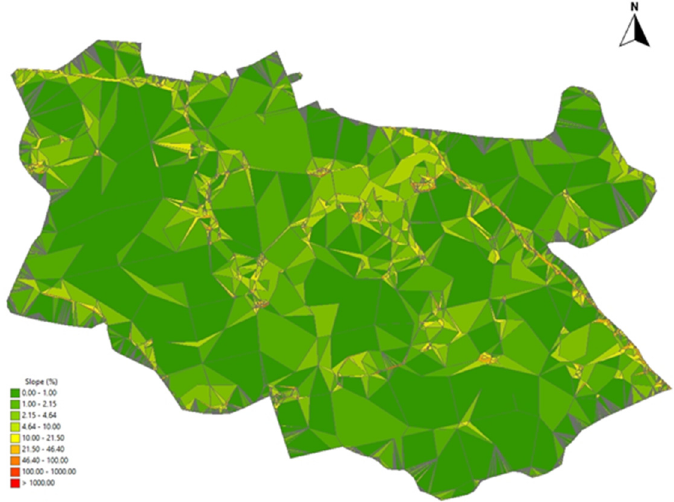
Figure A4. Slope (% rate)—Słu˙zewiecki Stream Catchment.